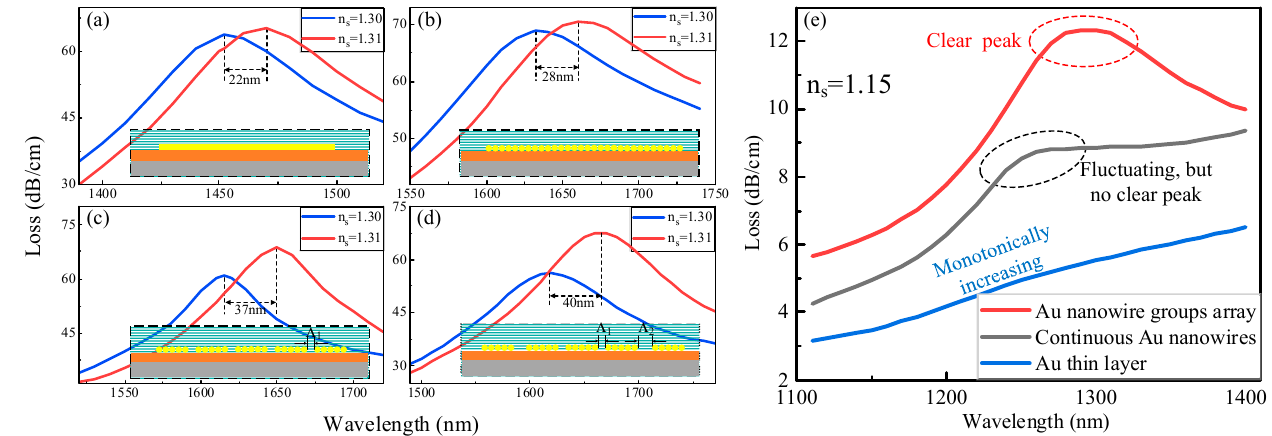
Figure 5. Loss analysis for different sensing regions at analytes 1.30 and 1.31. ( a ) Au thin layer; ( b ) Au nanowires; ( c ) Au nanowire groups array with Λ 1 = 70 nm spacing; ( d ) Au nanowire group array with Λ 1 = 70 nm and Λ 2 = 140 nm spacing. Detection range analysis ( e ) Au thin layer, continuous Au nanowires, and Au nanowire group array.